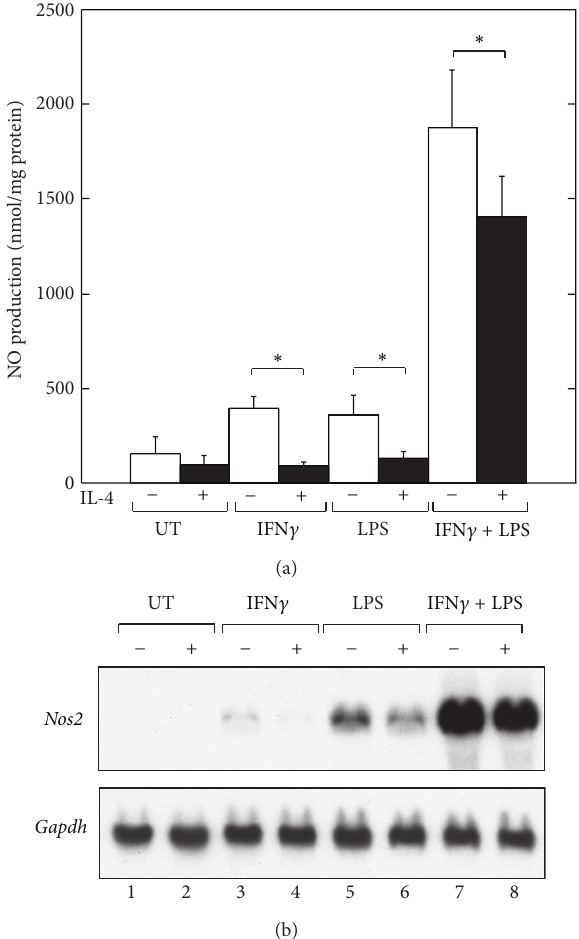
Figure 1: IL-4 inhibits IFN 𝛾 - and/or LPS-induced NO production and Nos2 mRNA expression in RAW264.7 cells. (a) RAW264.7 cells were treated with medium alone (untreated, UT) or IL-4 (10ng/mL) for 30 min prior to stimulation with IFN 𝛾 (10ng/mL) and/or LPS (100ng/mL). The culture supernatants were harvested and assessed forNOproductionbytheGriessassay.Theproteinconcentrationsof the residual cells in the cultures were also determined. Each column and bar represents the mean ± SEM of three independent exper- iments. The asterisks denote a statistically significant difference compared to the cultures with IL-4, ( ∗ 𝑃 < 0.05 ; Student’s 𝑡 test). (b) RAW264.7 cells were treated with medium alone or IL-4 (10ng/mL) for 30 min prior to stimulation with IFN 𝛾 (10ng/mL) and/or LPS (100ng/mL) for 8 hours before the preparation of total RNA and analysisofthe Nos2 mRNAlevelbynorthernhybridization.Thedata shown are representative of three independent